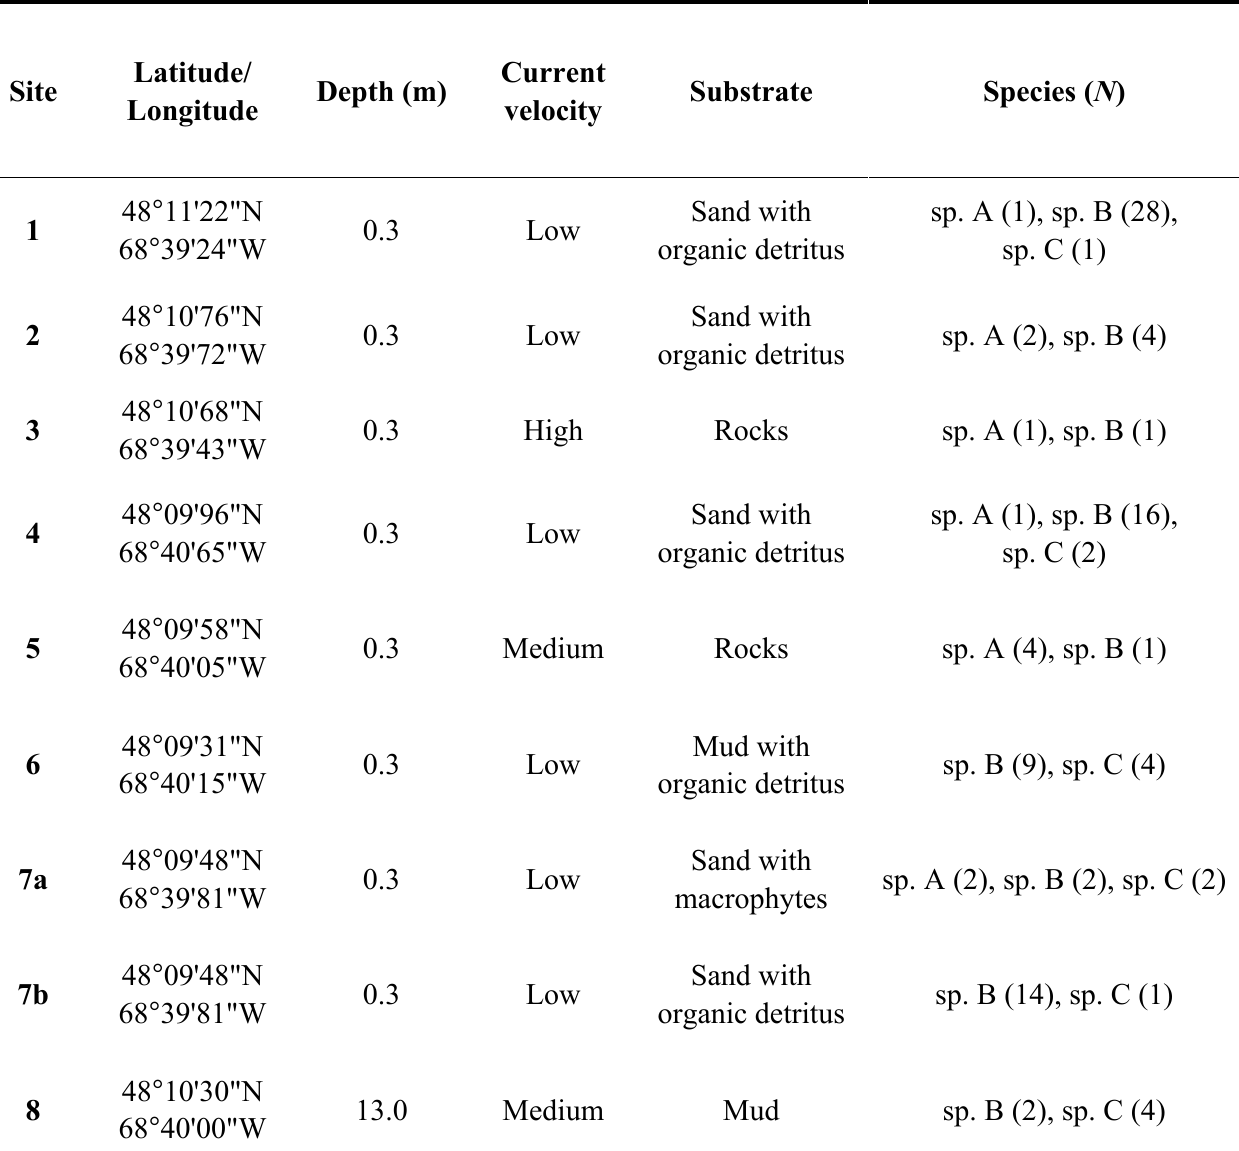
Table 1. Site characteristics and Hyalella species present for each site sampled in August 2007 and July 2008 in Lac des